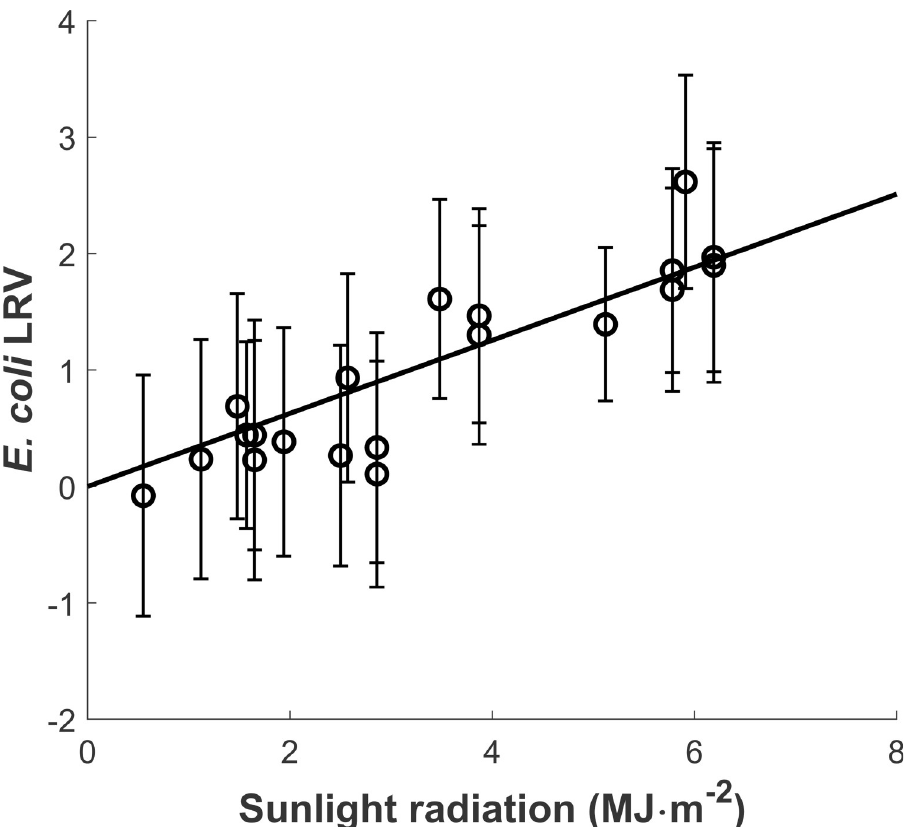
Fig 2. Effect of sunlight dose on E . coli log 10 removal at neutral pH during laboratory assays. The straight line represents the linear regression with null intercept peformed over the dataset (slope converted to the sunlight specific first order decay rate of 0.0624 m 2 � W -1 � d -1 by multiplying by the factor 24 � 3600 ½ s = d � = ð 10 6 ½ MJ = J �Þ � ln ð 10 Þ . An outlier confirmed by Grubb’s test on the residuals from linear regression was removed from the analysis. Error bars show measurement standard